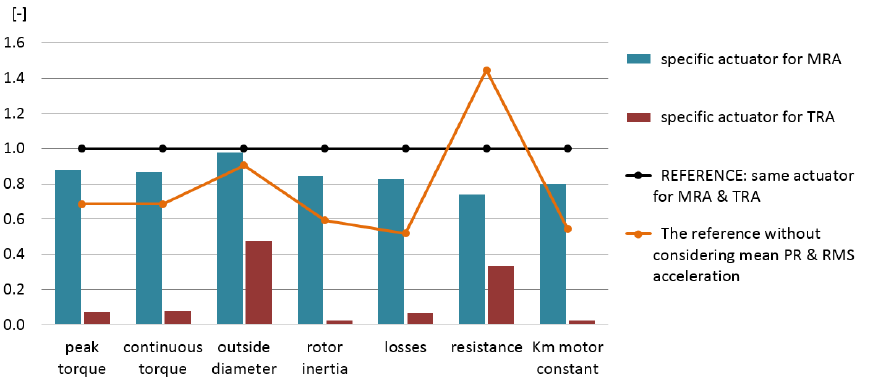
Figure 24. Motor characteristic evolution of specific actuators for the MRA and TRA applications compared to a unique actuator for both applications